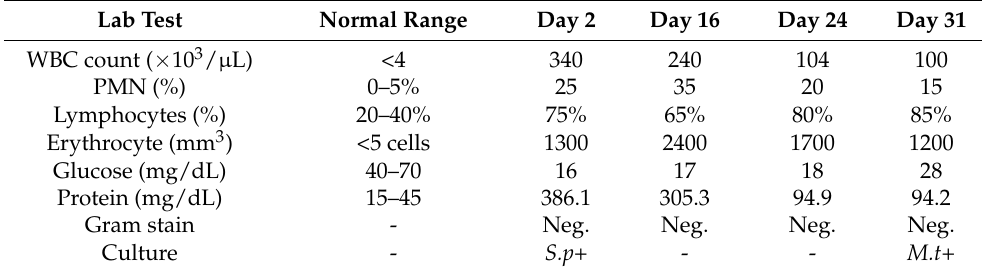
Table 1. Cerebrospinal fluid analysis.